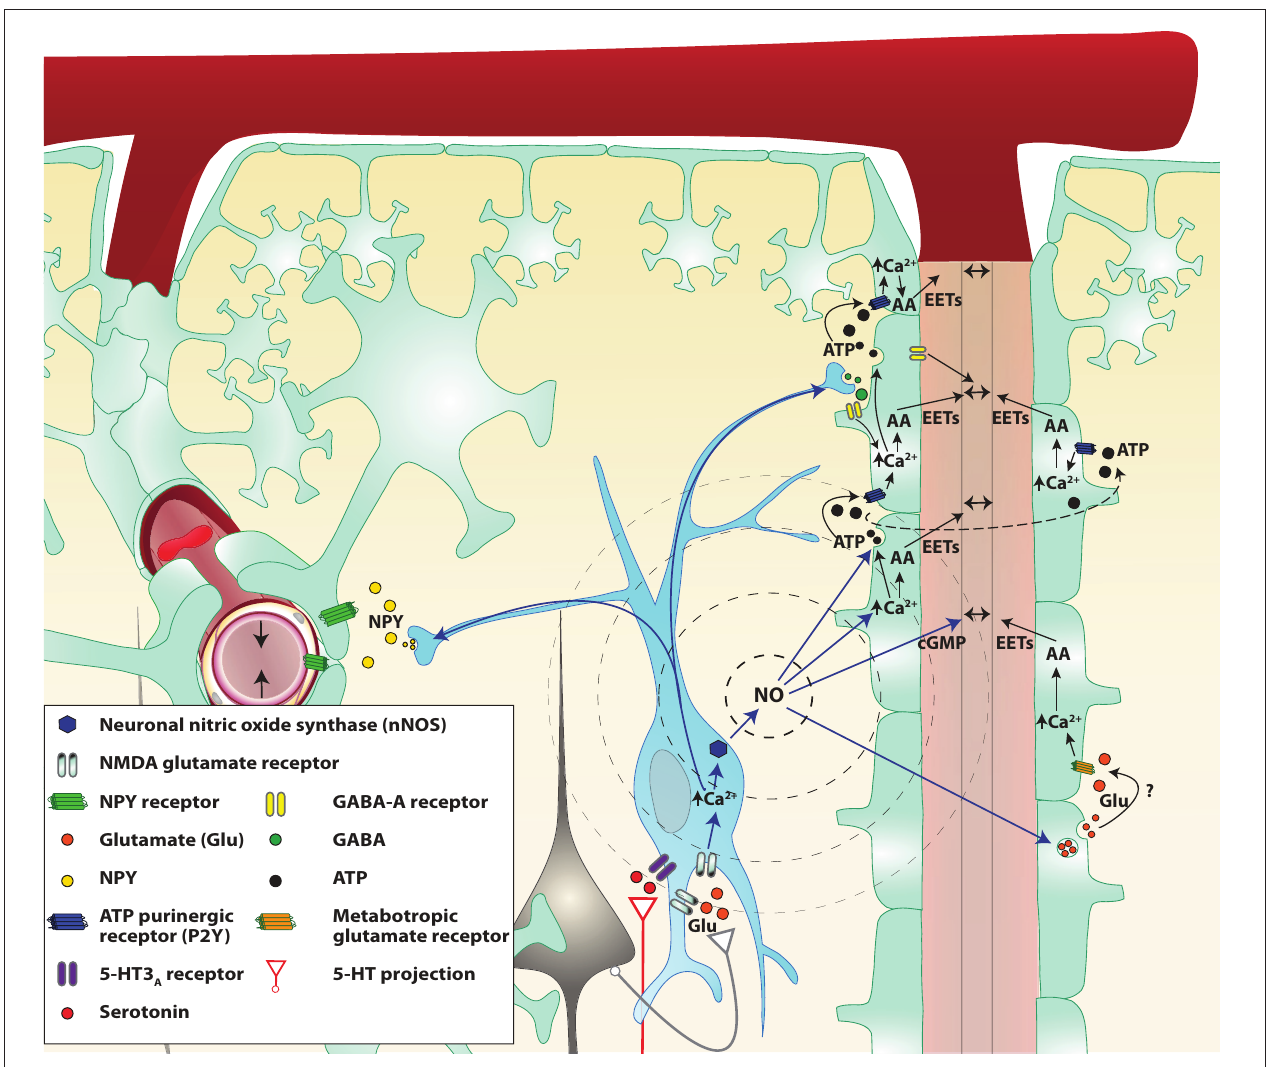
FIGURE 3 | Proposed mechanisms by which NO interneurons may propagate the signal in the cortex. Two parenchymal descending arteries (left and right of the figure) are branching from a pial artery. Astrocytes (light green cells) cover descending arteries with their specialized projections: the astrocytic endfeet, with the exception of the pial artery and parenchymal arteries portion separated by the Virchow–Robin space. Following local neuronal activity, pyramidal cells (black cells) stimulate nitrergic interneurons (blue cell), through their glutamate NMDA receptors. The influx of calcium (Ca 2 + ) in the cell allows activation of the neuronal NO synthase (nNOS) and the production of NO. NO diffuses freely through cell membranes and reaches the astrocytic endfeet where it could modulate the release of various vasoactive metabolites. NO may be involved in retrograde vasodilation